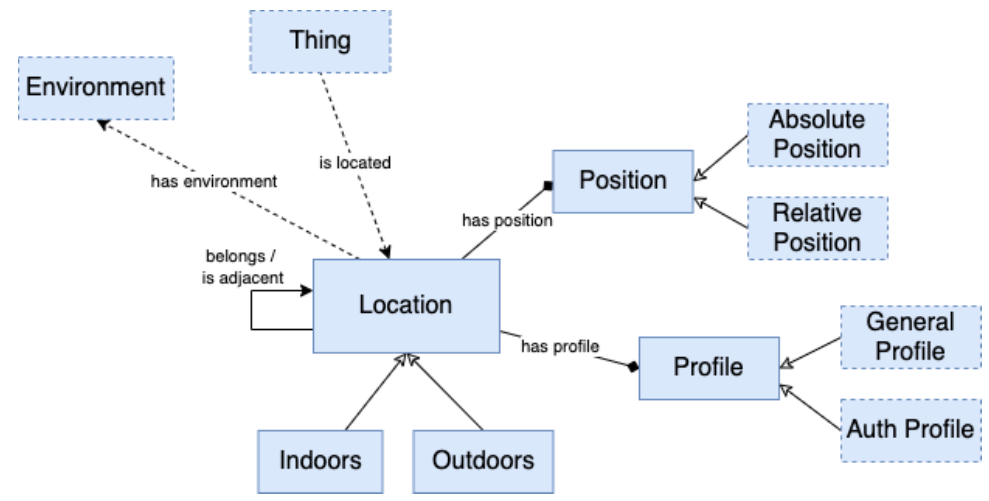
Figure 3. Location class.